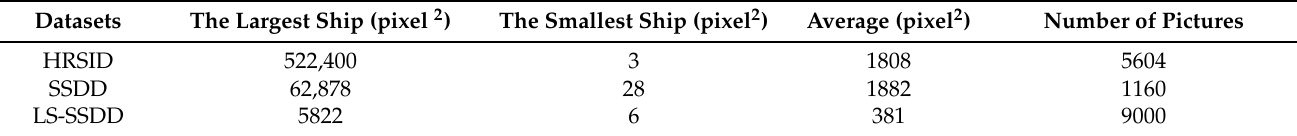
Table 1. Statistics of